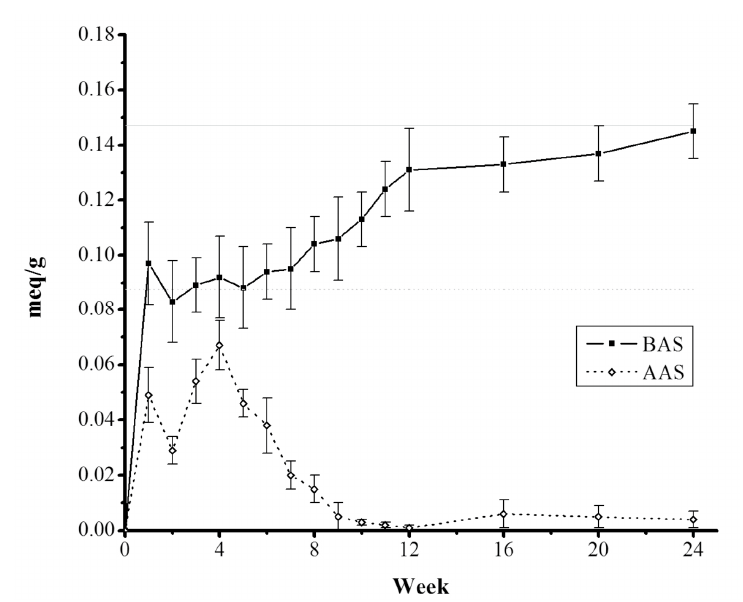
Figure 7. Concentration of active sites (mean ± standard error) by week of biofilm development, basic active sites (BAS) and acid active sites (AAS). Control concentration at 0.147 and 0.087 meq/g, respectively.